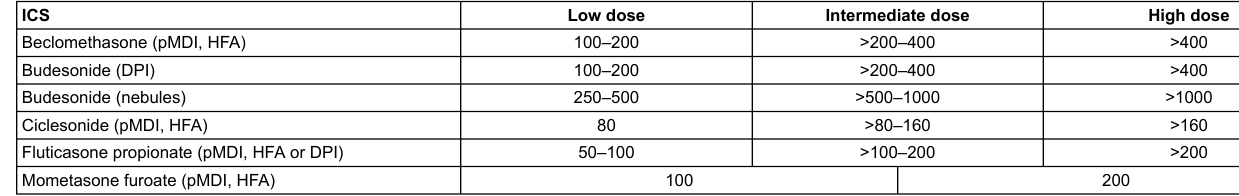
Table 3a: Total inhaled corticosteroid dose (μg/day) in children 6–11 years old. ICS Low dose Intermediate dose High dose